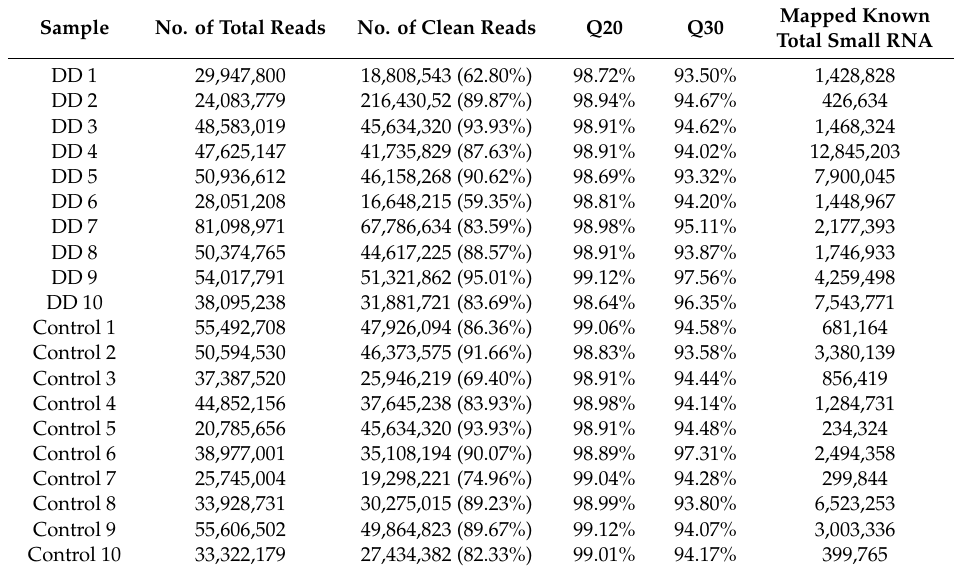
Table 2. Quality characteristics of the original sequencing